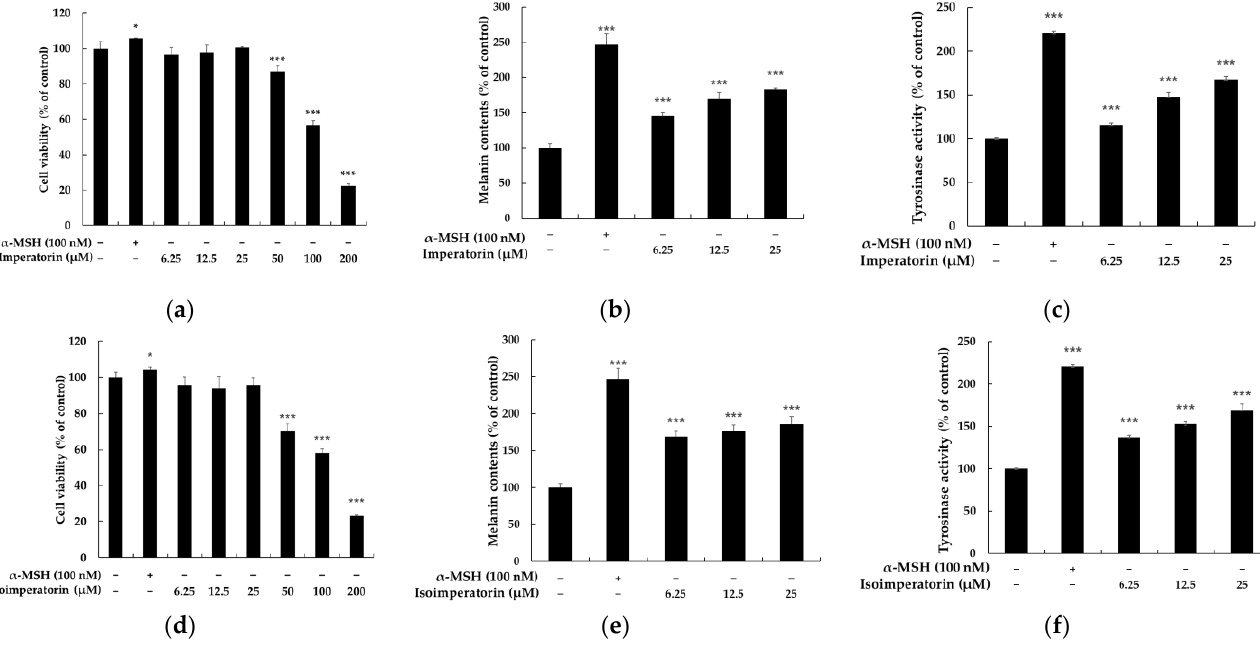
Figure 2. The effects of imperatorin and isoimperatorin on the viability ( a , d ), melanin production ( b , d ), and tyrosinase activity ( c , e ). Cells were plated in 24-well plates (1 × 10 4 cells/well) for 24 h and then treated with imperatorin and isoimperatorin (200, 100, 50, 25, 12.5, and 6.25 μM) for 24 h. The cytotoxicities of imperatorin and isoimperatorin were evaluated using MTT assays. For the evalua- tion of melanin production and tyrosinase activity, cells were placed in 60 mm cell culture dishes (7.0 × 10 4 cells/dish), incubated for 24 h, and then treated with imperatorin and isoimperatorin (25, 12.5 and 6.25 μM) for 72 h in the presence of α - MSH (100 nM). α -MSH treatment was used as the positive control. The results are presented as the mean ± SD from three independent experiments.